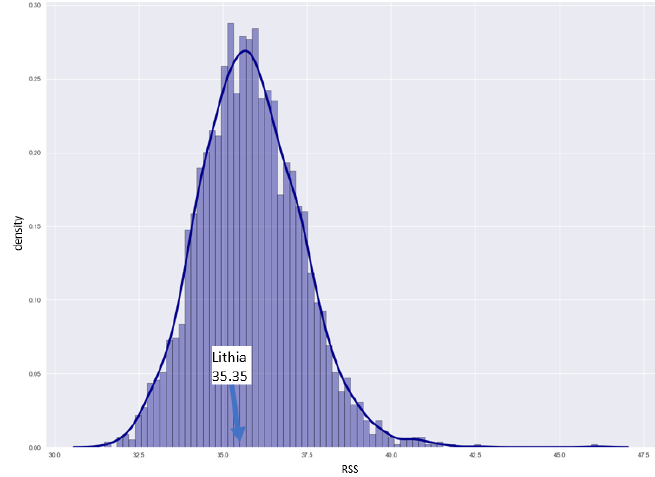
Figure 5. RSS distribution of meteorological data from Argos Orestiko vs. Lithia.